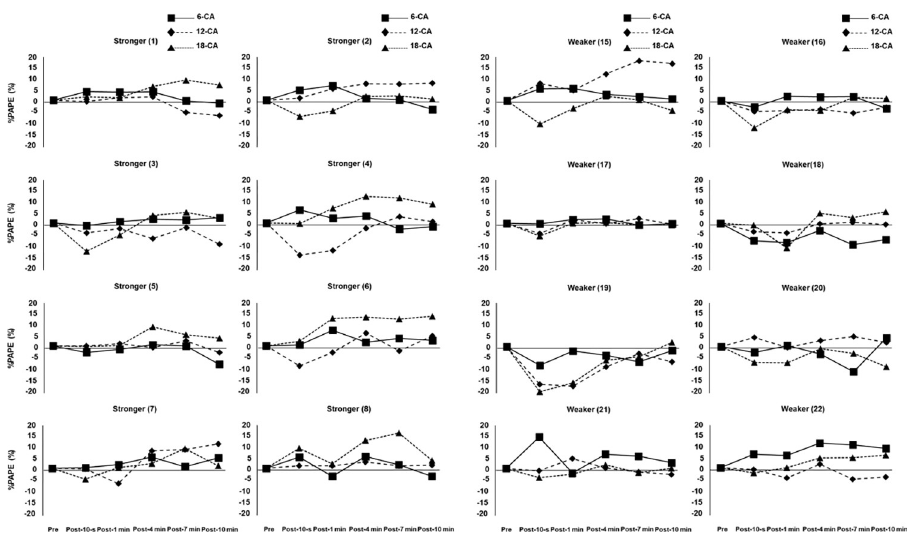
Fig 6. Time-course changes in %PAPE after each CA for each individual. The number in parentheses indicates how high the individual’s relative muscle strength was from the top among all participants. CA, conditioning activity.